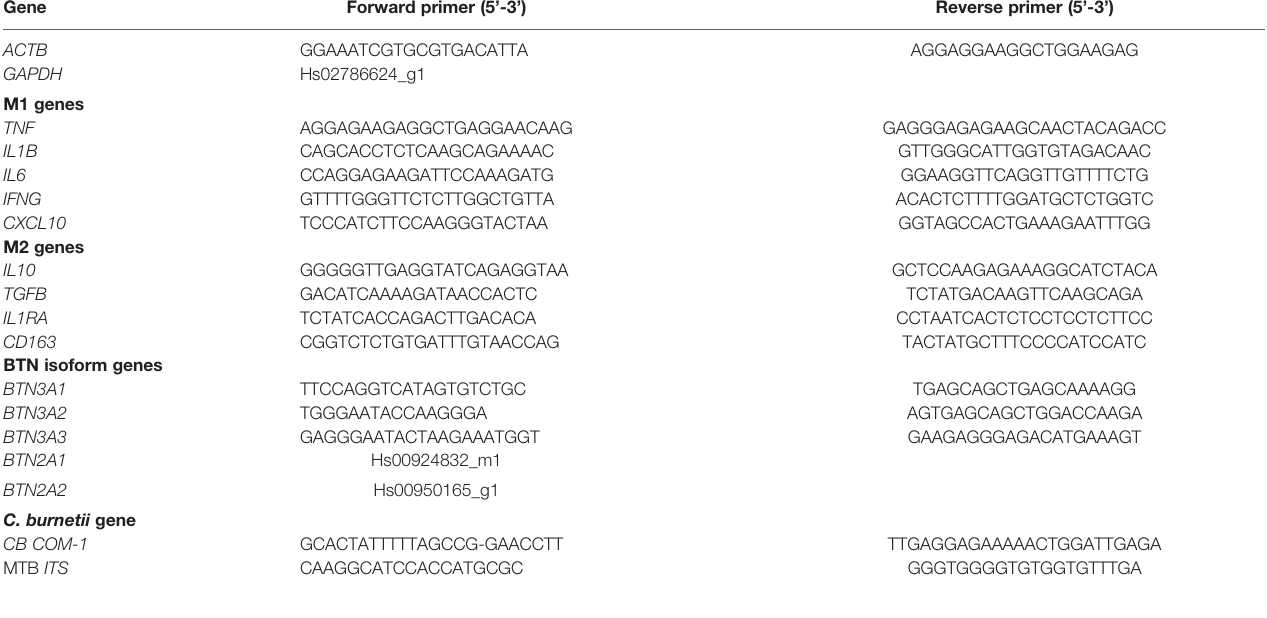
TABLE 1 | Primers used for the response to